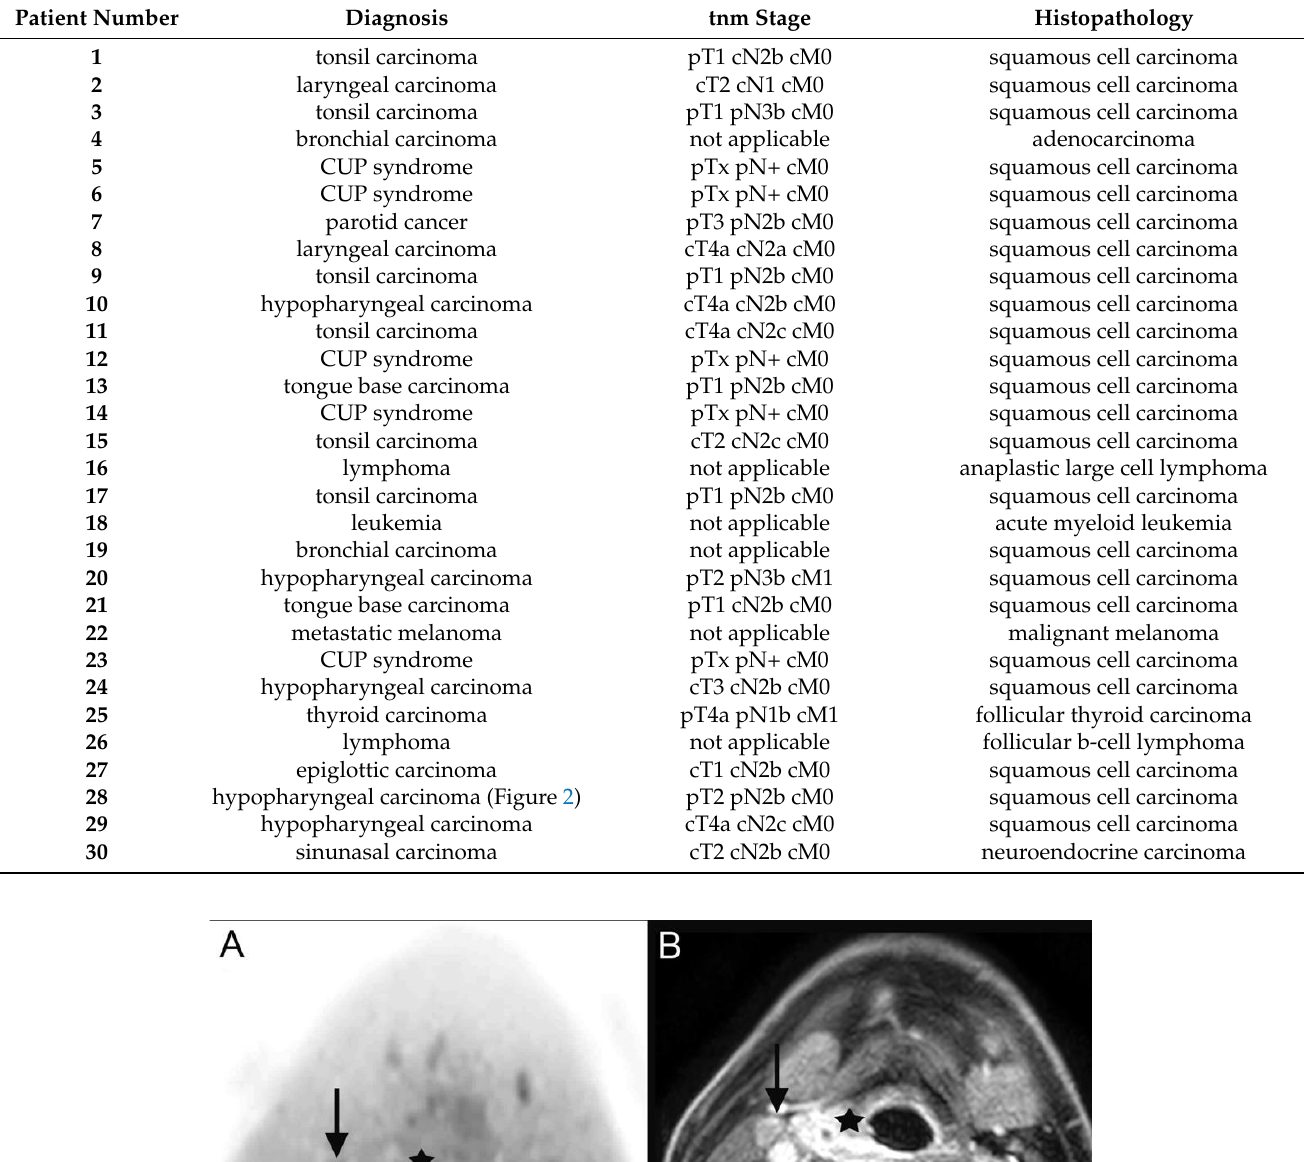
Table 2. Final diagnosis and TNM stage as well as histopathologic subtype of all included patients with clinically suspected head and neck carcinoma and cervical nodal swelling.